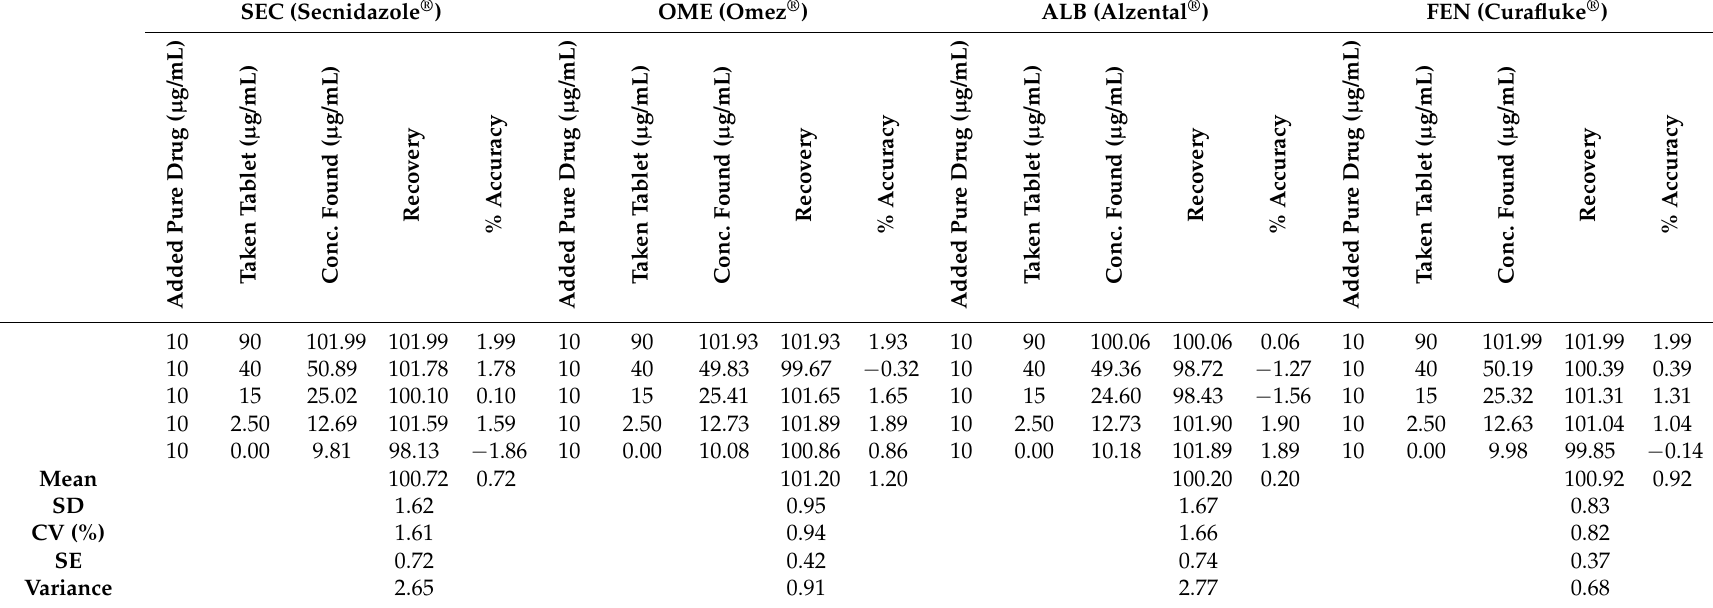
Table 4. Application of standard addition technique for the determination of Secnidazole ® , Omez ® , Alzental ® , and Curafluke ® dosage forms using the proposed